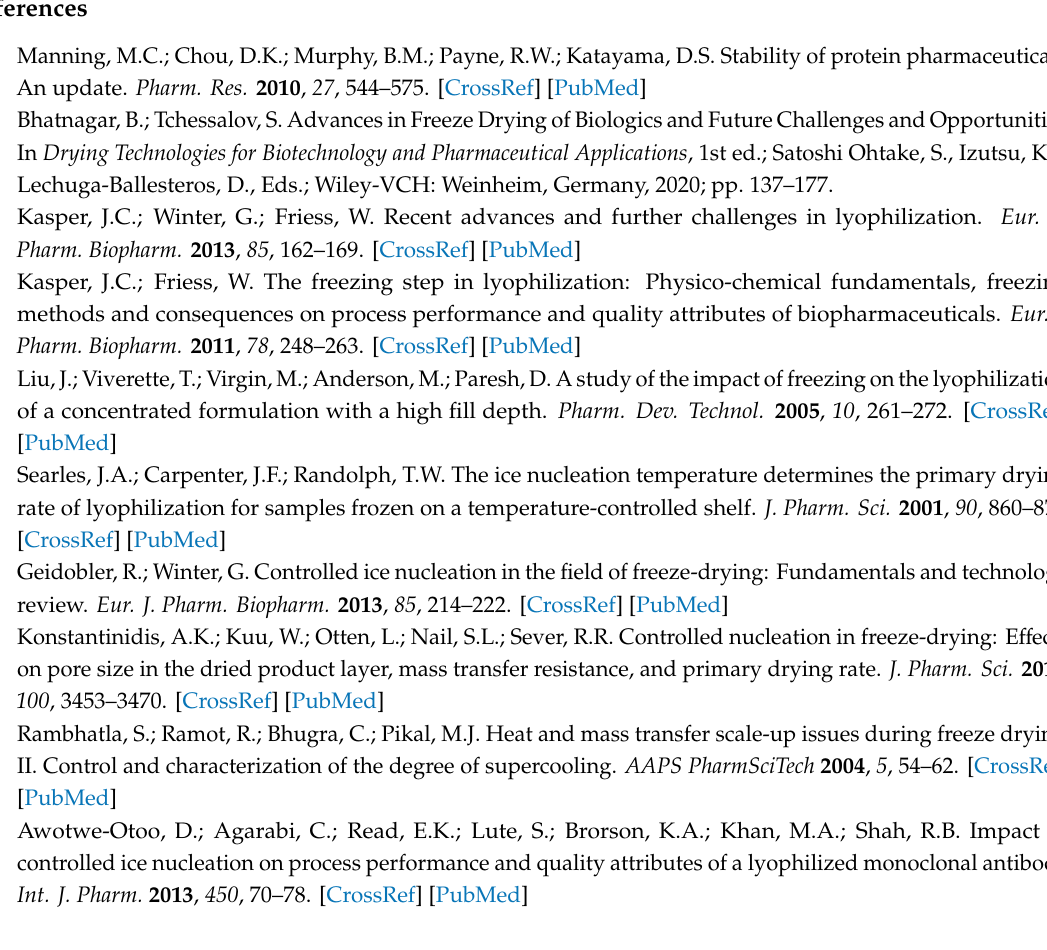
Figure A2. Process monitoring data for 5.4 mL and 10.6 mL fill volumes for controlled (ctrl.) and uncontrolled (unctrl.) nucleated samples. The product temperature (Tp) was determined by thermocouples that were attached to the outside of the vial. The chamber pressure was measured by a Pirani gauge and an MKS10 probe. ( a ) Primary drying. ( b ) Secondary drying.